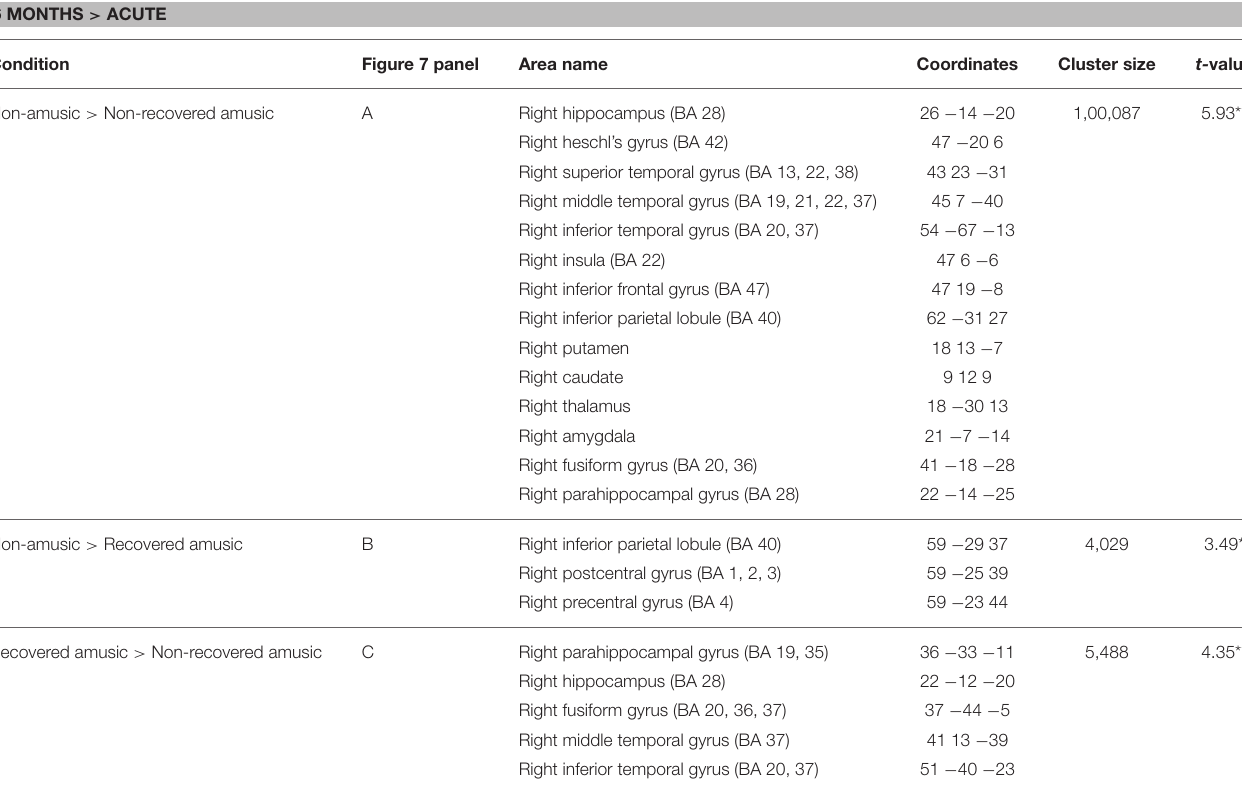
TABLE 6 | Gray matter volume decreases (6-month stage—acute stage) in rhythm amusia: pooled